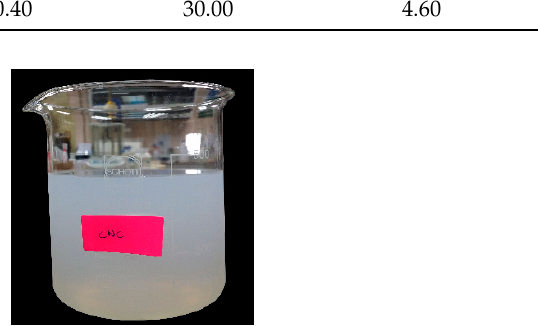
Figure 1. AA mixed with the stable redispersed freeze-dried CNC suspension.